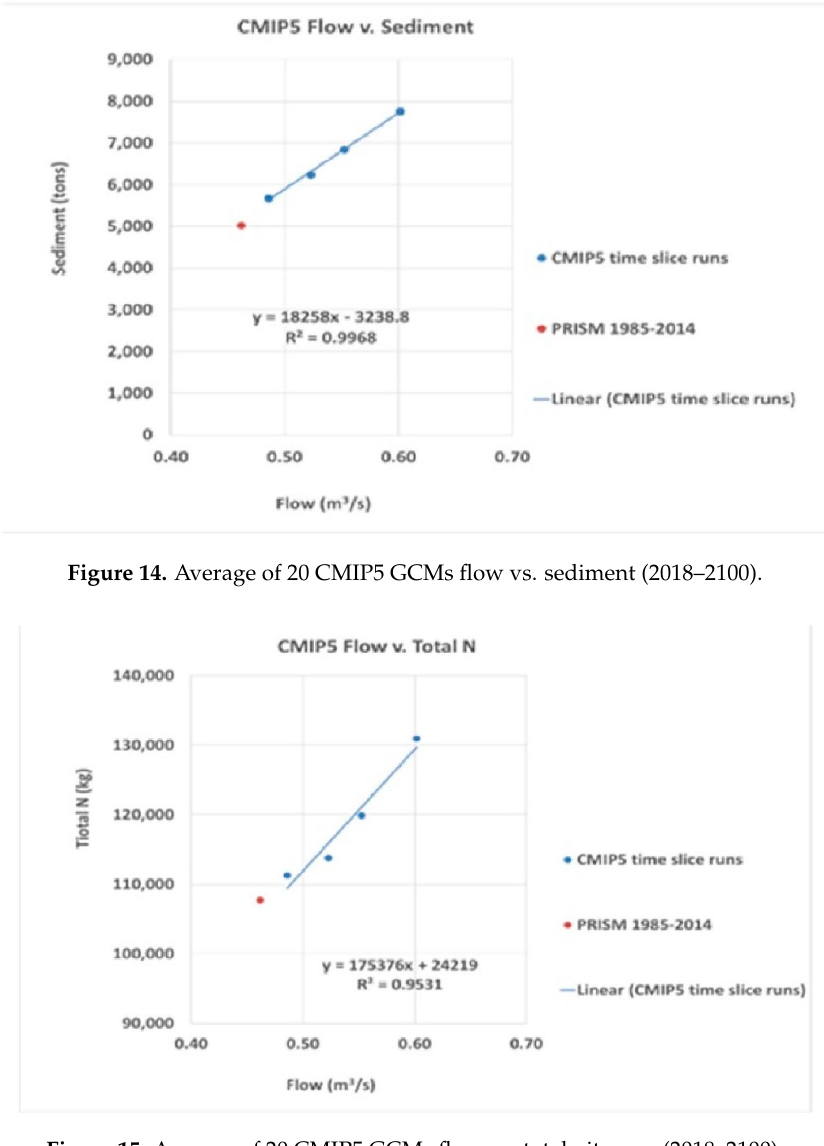
Figure 15. Average of 20 CMIP5 GCMs flow vs. total nitrogen (2018–2100).